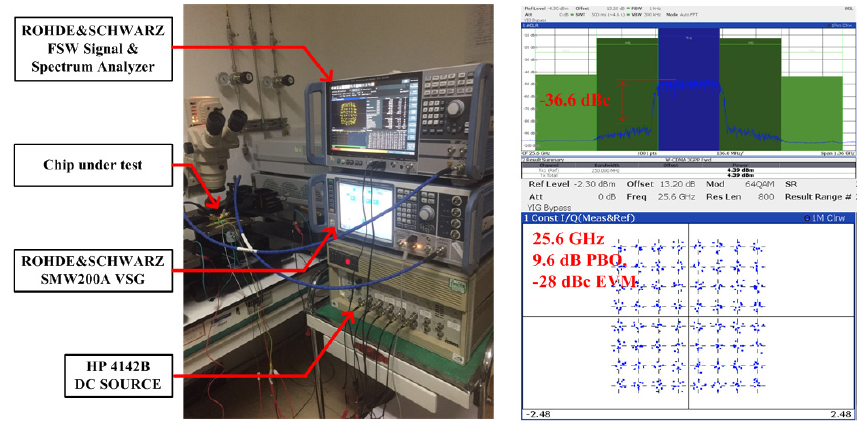
Figure 8. The measurement setup for adjacent channel power ratio (ACPR) and error vector magnitude (EVM) and the measured results at 25.6 GHz operation frequency and 9.6 dB power back-off (PBO).